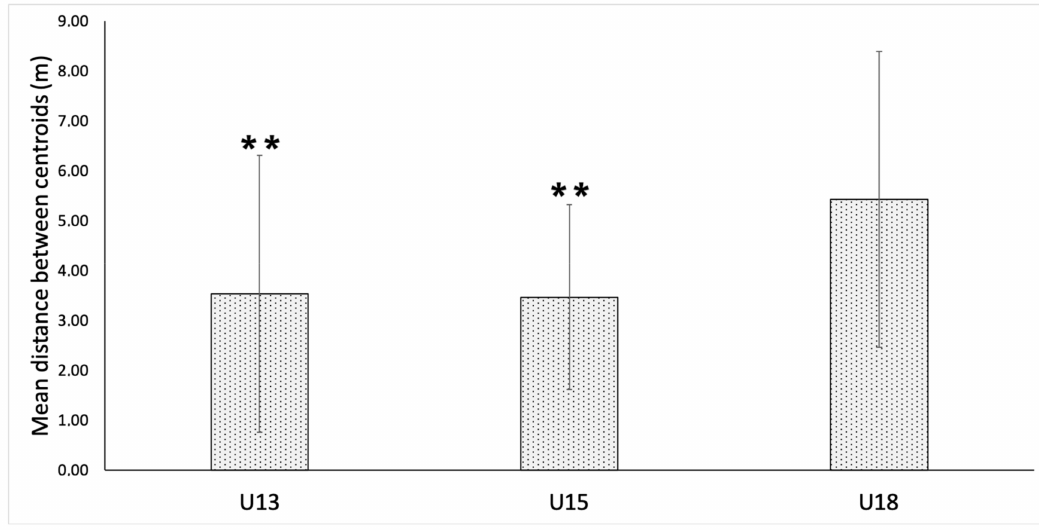
Figure 2. Teams’ centroid distance recorded during the 4 vs. 4 small-sided game (SSG) plus goalkeepers according to age-level groups. ** p < 0.001, di ff erences with U18 age-level group. Table 2. Mean distance recorded among the four players of each team and from players to the centroid during the 4 vs. 4 small-sided game (SSG) plus goalkeepers according to age-level groups. U13 vs. U15 U13 vs. U18 U15 vs. U18 Tactical Variables U13 U15 U18 ( p ; ES) ( p ; ES) ( p ; ES) Mean distance among 10.43 ± 2.91 11.72 ± 2.76 12.79 ± 4.33 0.000; 0.44 0.000; 0.81 0.000; 0.39 players per team (m) Stretch index (m) 7.76 ± 2.34 8.86 ± 2.50 9.50 ± 3.87 0.000; 0.47 0.000; 0.75 0.000;